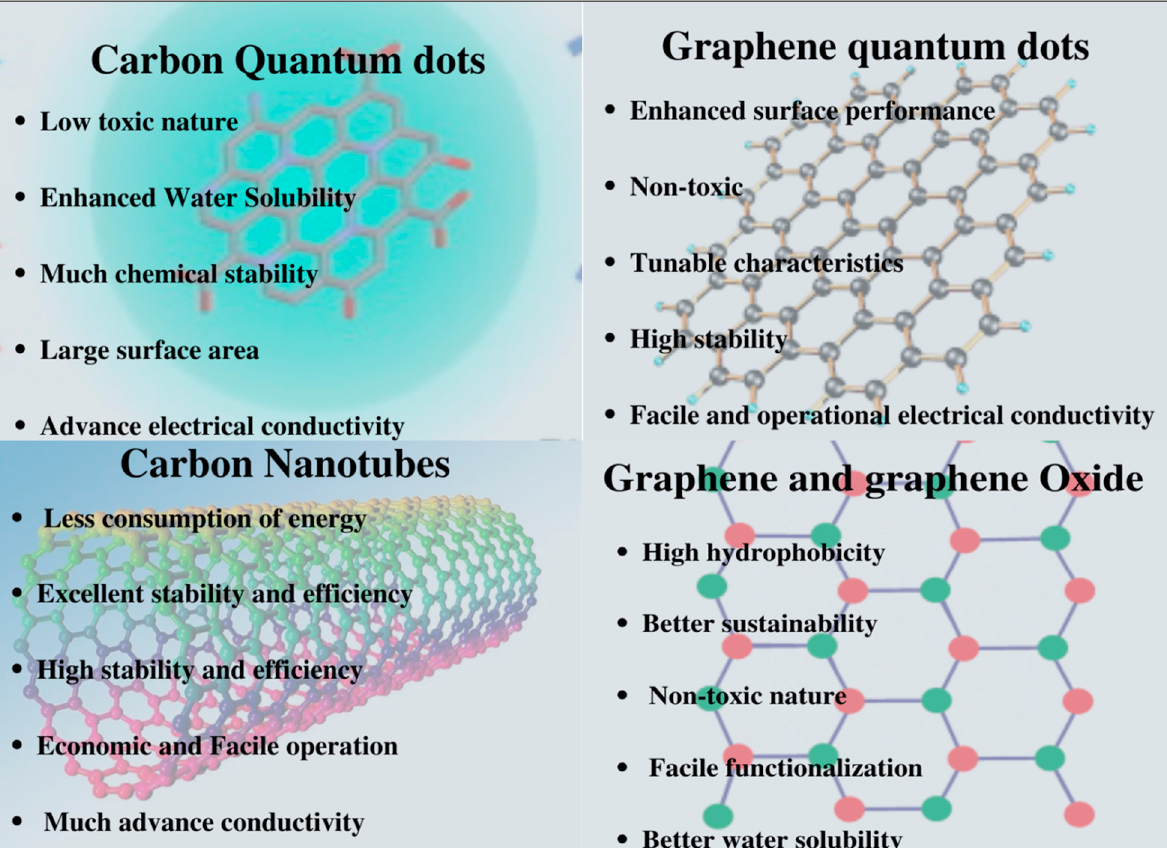
Figure 2. Various carbon-based NMs and their number of distinct advantages.